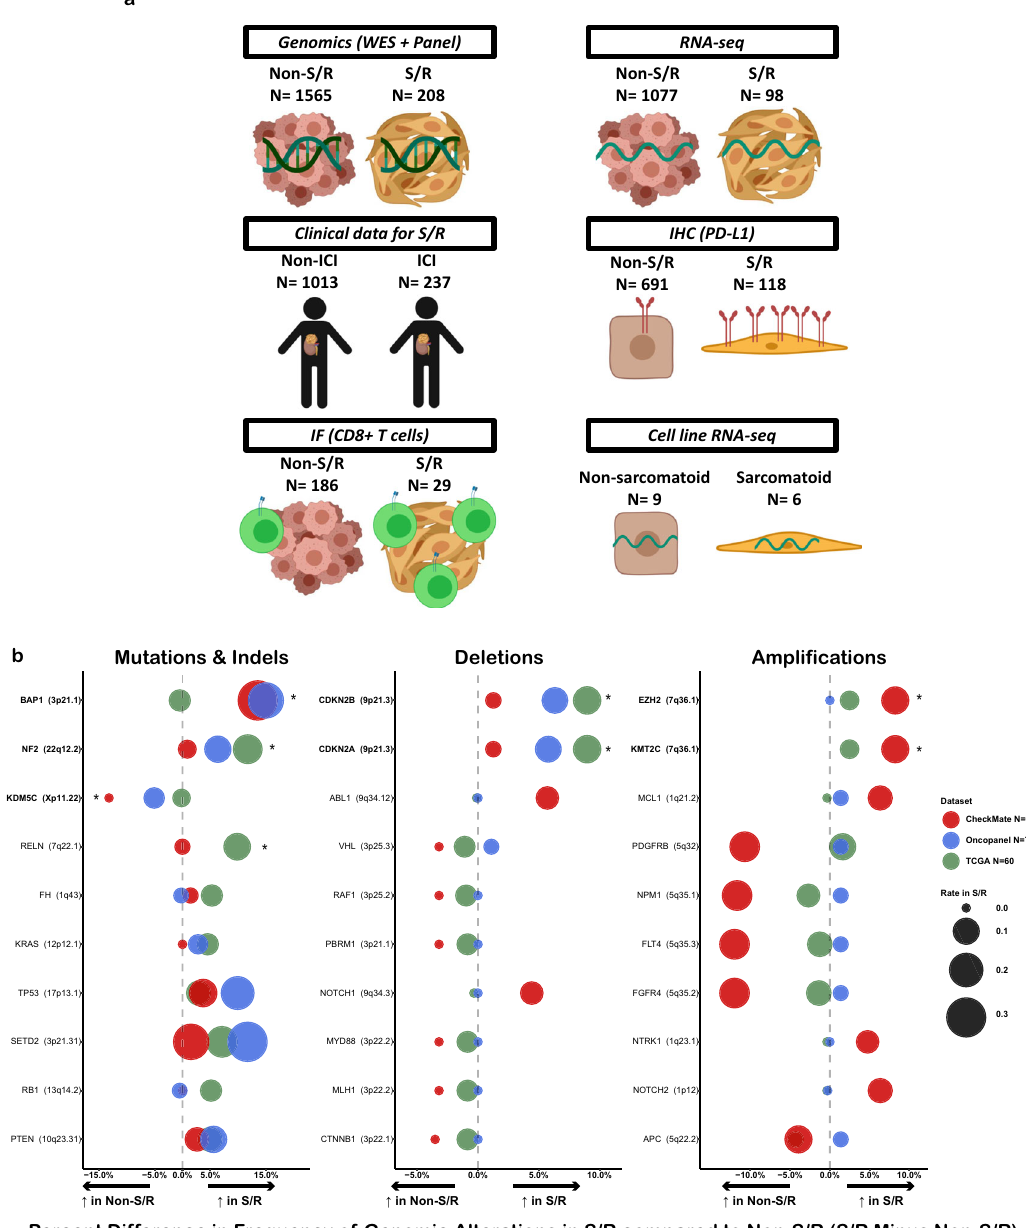
Fig. 1 Genomic characterization of S/R RCC reveals distinctive genomic features. a Overview of the clinical, molecular, and cell line data. ( b ) Comparison of S/R vs. non-S/R RCC by mutations & indels, deletions, and ampli fi cations in the CheckMate, OncoPanel, and TCGA cohorts. * q < 0.05 (Fisher ’ s method meta-analysis of Fisher ’ s two-sided exact tests); ICI: Immune Checkpoint Inhibitor; IF: Immuno fl uorescence; IHC: Immunohistochemistry; RNA-seq: RNA- sequencing; S/R: Sarcomatoid/Rhabdoid; TCGA: The Cancer Genome Atlas; WES: Whole Exome reticulum [ER] stress and apoptosis-caspase pathway) 1,4 , and enriched in S/R RCC. Moreover, the correlation with outcomes rapid progression (E2F targets, G2/M checkpoint, mitotic spindle within S/R RCC of the MYC v1 score was consistent when the assembly). Moreover, high MYC targets version 1 (v1) expression MYC -regulated transcriptional program was measured using the as quanti fi ed by single sample GSEA (ssGSEA) scores 21 sig- separate but related MYC v2 “ Hallmark ” gene set (Supplementary ni fi cantly correlated with worse clinical outcomes in both the Fig. S5b, c). Patients with non-S/R RCC and MYC v1 scores subset of patients with S/R in the anti-PD-1 (nivolumab) arm of similar to those of S/R RCC (above the median of the S/R RCC the CheckMate cohort as well as the subgroup of stage IV S/R group for MYC v1) had signi fi cantly worse outcomes in both the RCC patients in TCGA independently (Fig. 2b; Supplementary TCGA and CheckMate PD-1 cohorts (Fig. 2c; Supplementary Fig. S4; Supplementary Data 6). Of note, the majority of founder Fig. S4; Supplementary Data 6). These results indicate that a MYC - gene sets of both the MYC v1 and v2 “ Hallmark ” gene were driven transcriptional program is driving the aggressive phenotype enriched in S/R RCC (Supplementary Fig. S5a), further corro- of S/R RCC tumors (also shared with a subset of non-S/R borating the fact that MYC -regulated transcriptional programs are RCC) 2 .